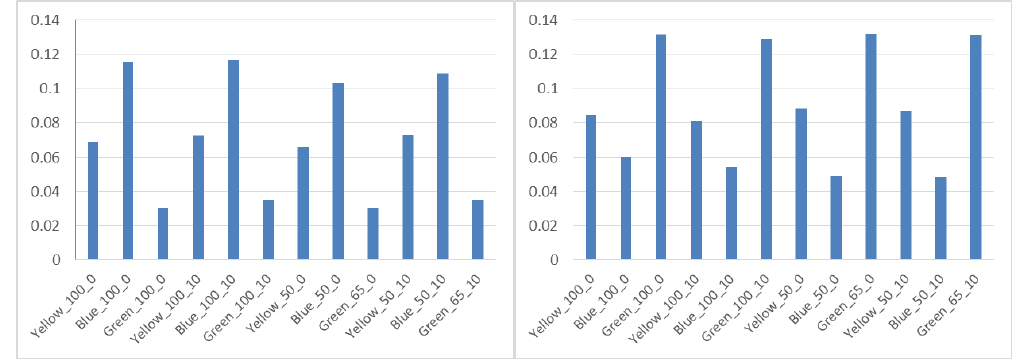
Figure A1. Euclidian distance of scenarios and their variants to positive-ideal ( left ) and negative-ideal ( right ) alternatives. Source: Own compilation.